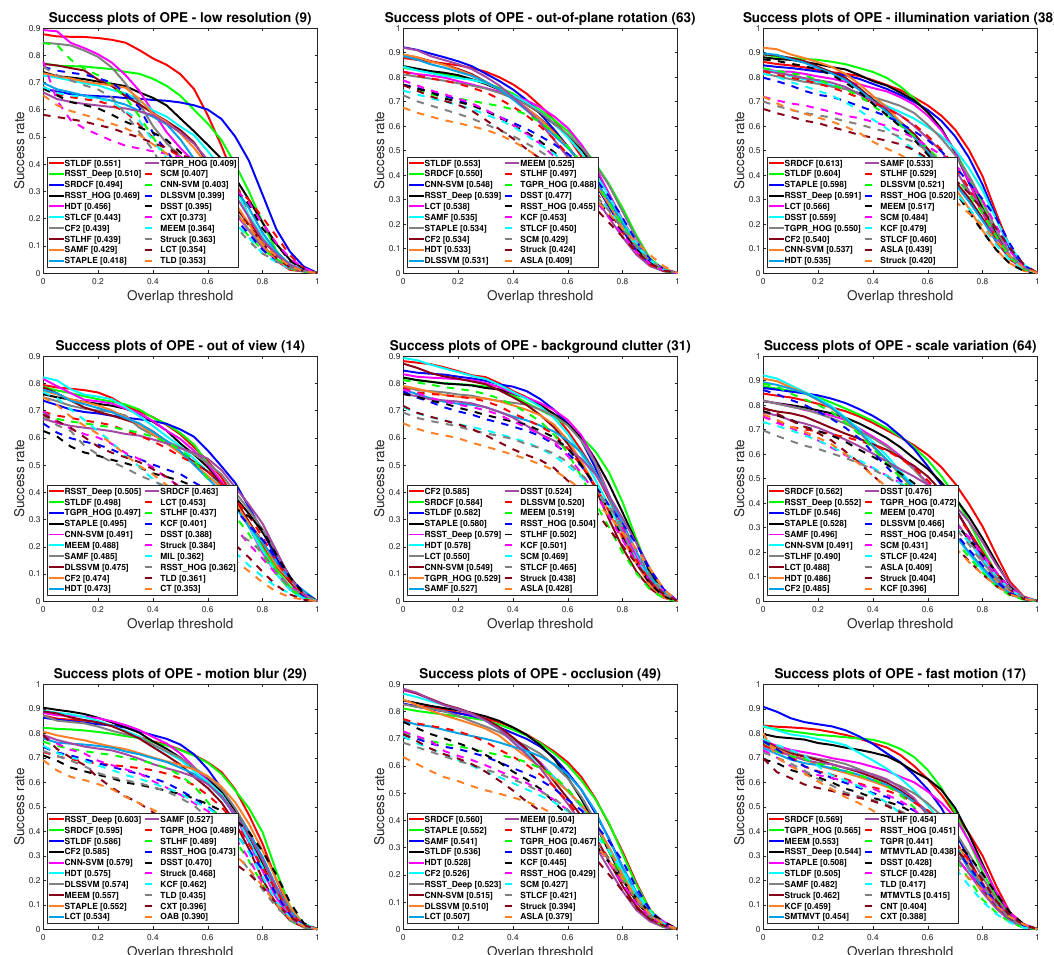
Figure 4. The OPE success plots for LR, OPR, IV, OV, BC, SV, MB, OCC, and FM subsets in